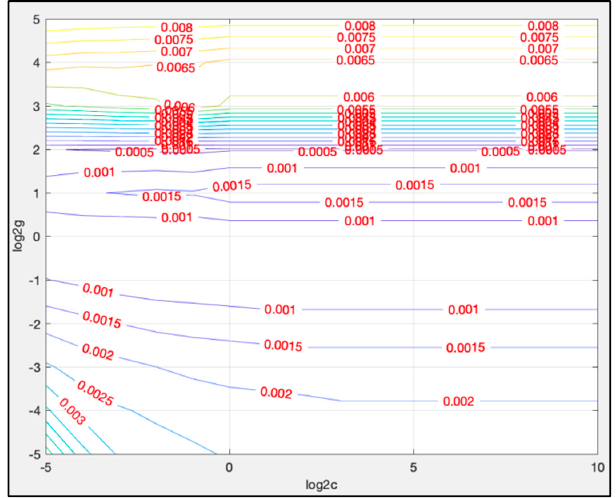
Figure 11. Result of coarse selection.